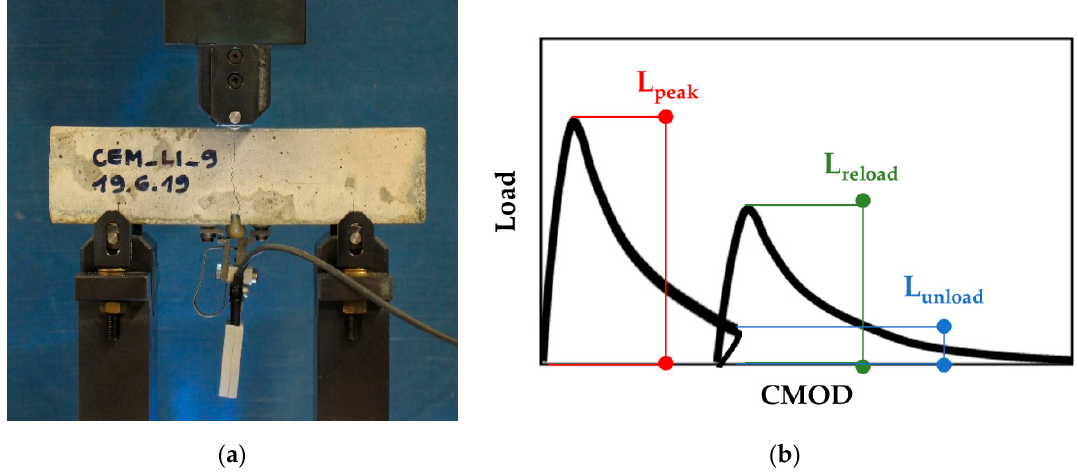
Figure 6. ( a ) Experimental setup for the static reloading procedure; ( b ) schematic load versus crack mouth opening displacement (CMOD) curves related to pre-cracking and reloading, with indication of maximum and residual load-bearing